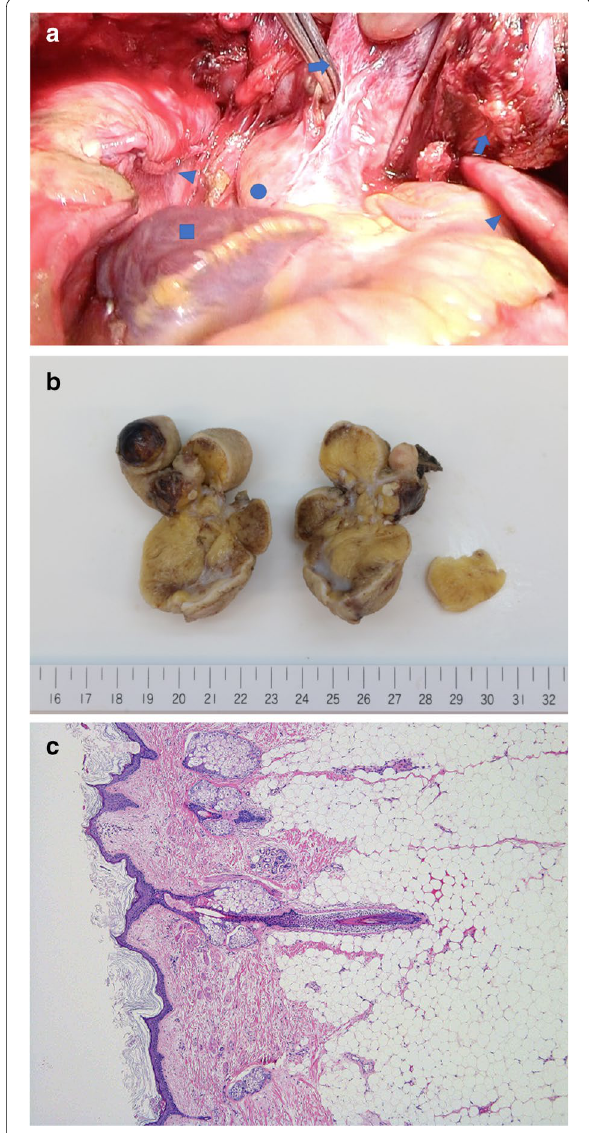
Fig. 2 a Intraoperative findings showing adhesion of the tumor (arrow) to the ascending aorta (circle) after resection of the pericardium and right upper lung. The bilateral lungs are marked with triangles and the right auricle is marked with a square. b The tumor consisted of an 85 55 mm solid mass and a 90 50 mm × × cystic mass with severe adhesion to the resected portion of the lung, which included skin and lipid tissue. c Hematoxylin–eosin staining of the tumor specimen demonstrating that the inner cavity of the cystic tumor was lined mainly with skin, which was composed of keratinized squamous epithelium, sebaceous and sweat glands, hair follicles, and smooth muscle. The tumor also contained adipose tissue and bronchial elements. The wall of the tumor demonstrated necrotizing inflammation, with the infiltration of many neutrophils, lymphocytes, and macrophages. Neither an immature component nor malignant transformation was observed (low power